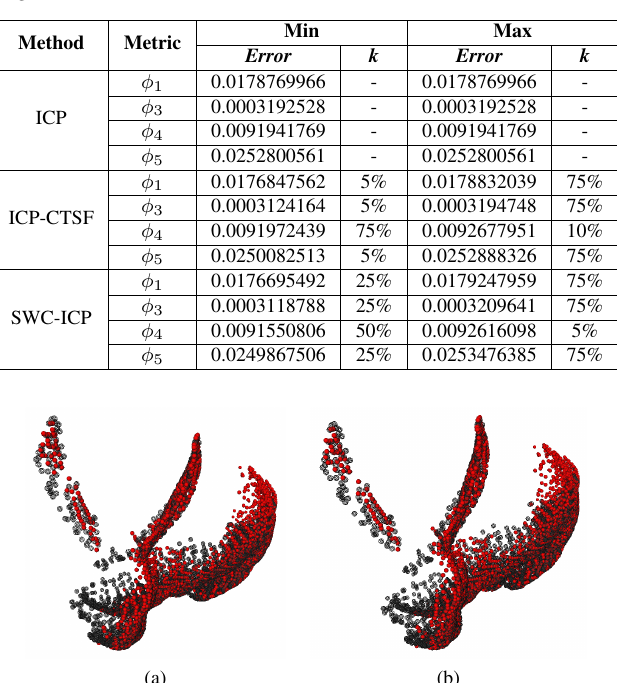
Fig. 6: Visualization of the best cases reported in Table I: (a) Sparse ICP. (b) Sparse ICP CTSF with k = 25% .